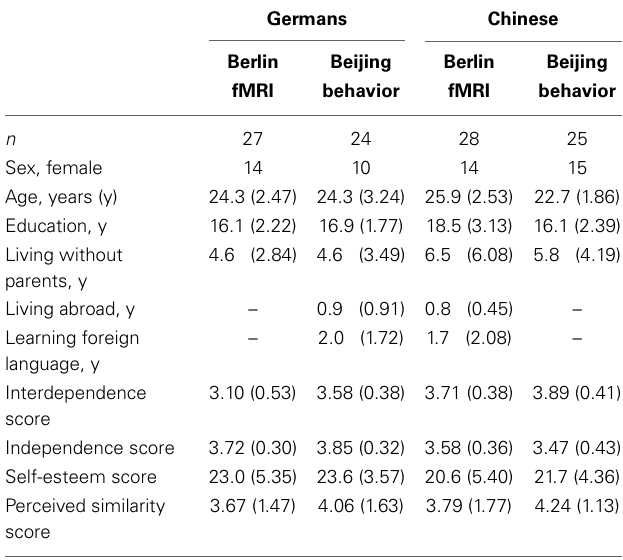
Table 1 | Characteristics of participants (data are given as mean and standard